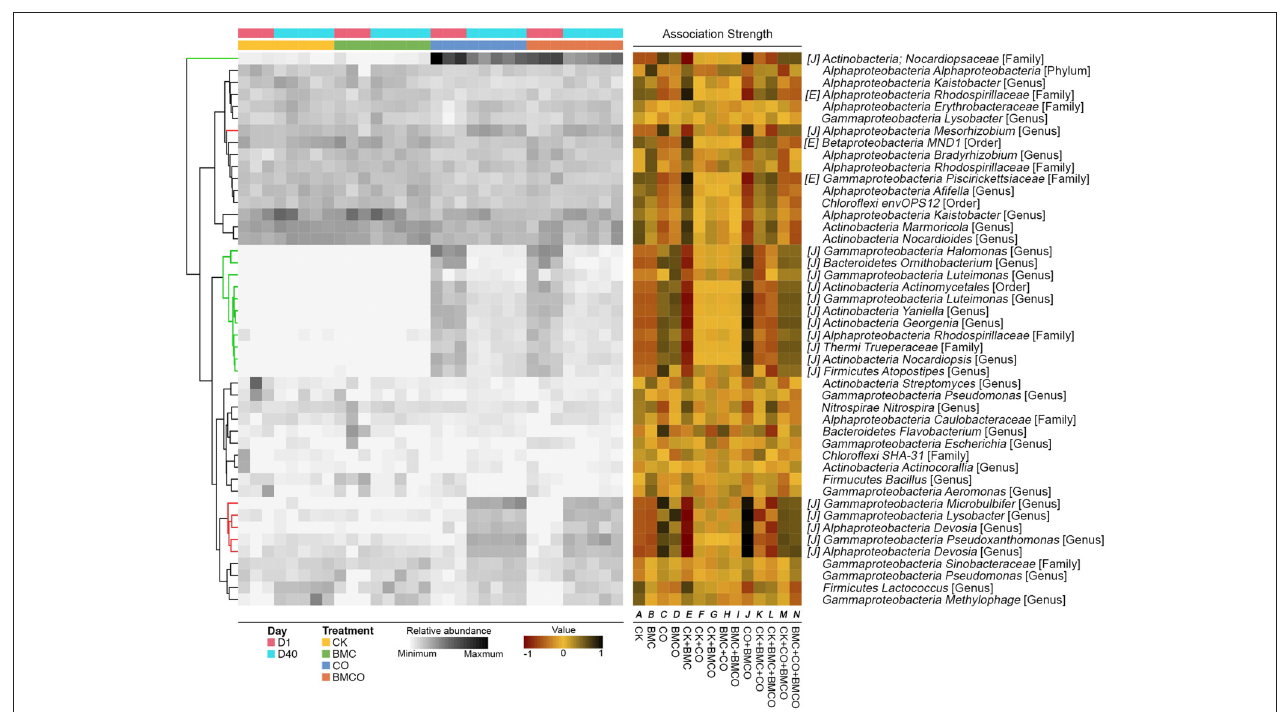
FIGURE 3 | Bacterial operational taxonomic units (OTUs) identified by indicator analysis as indicative species of each treatment or the combination of treatments. The heatmap in the left-hand portion of the panel shows relative abundance ( > 1% in at least one sample) of OTUs across all samples. OTUs are clustered using unsupervised hierarchical clustering based on relative abundance. The green portion of the tree encompasses OTUs that are introduced by compost whereas the red portion encompasses soil indigenous OTUs that are stimulated by compost. Association strength is presented in the middle portion of the panel, with “strength” for a given OTU defined as its preference for corresponding treatment or combination of treatments ( − 1, avoiding the site; + 1, prevailing in the site). The letters in square brackets denotes OTUs that had significant association strength with corresponding treatment or combination of treatments ( P adjust < 0.05). The OTU names are formatted as: name of class level ; name of the lowest classified level [the lowest classified level]. A full list of indicative OTUs is provided in Table